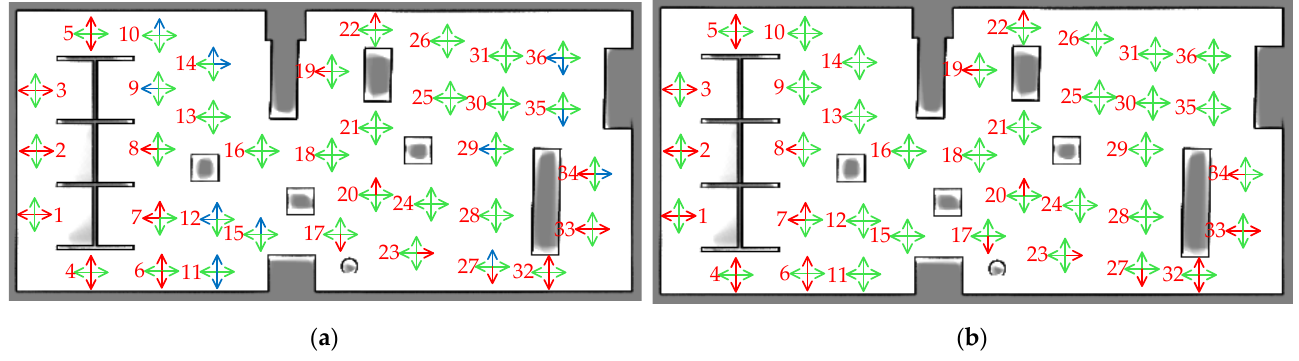
Figure 8. Record result of relocation ( a ) The posenetLSTM method; ( b ) The method proposed in this paper.